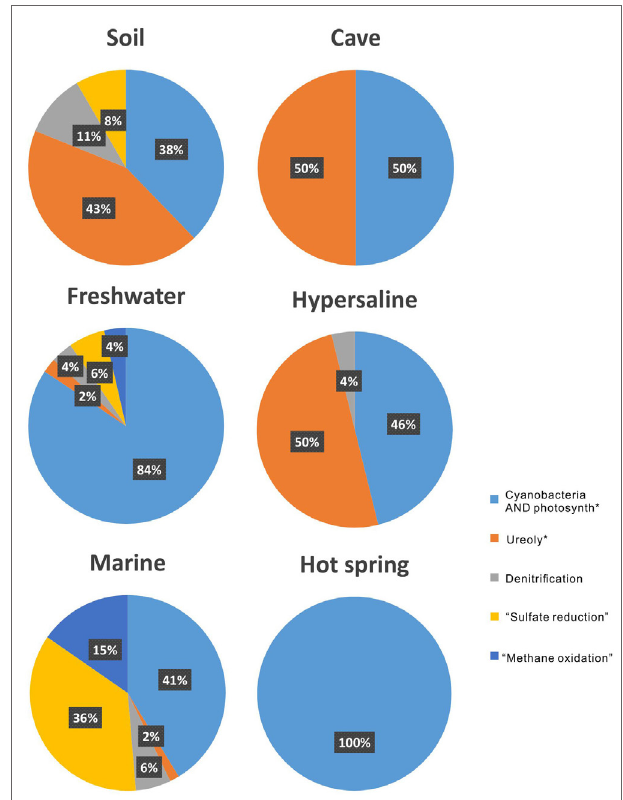
FiGURe 4 | The proportion of metabolisms that induced microbial carbonate precipitation in each